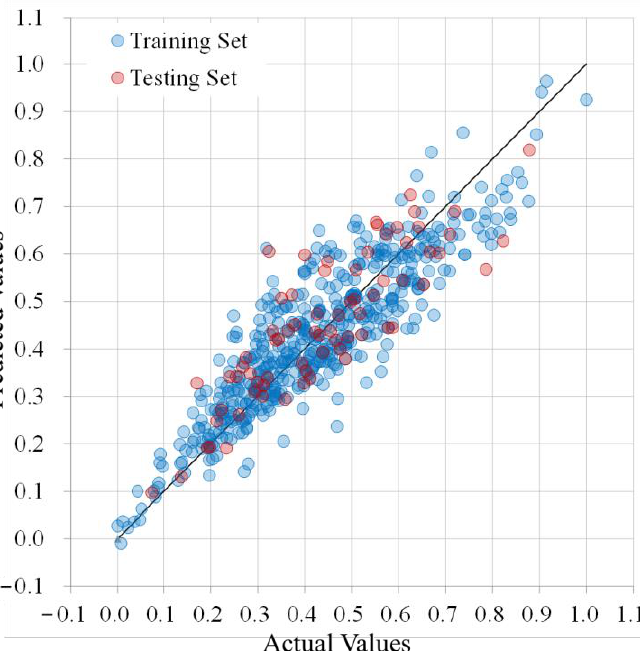
Figure 2. The comparison of the outputs of ANN with their target values in which the ANN only has 3 RBFs.